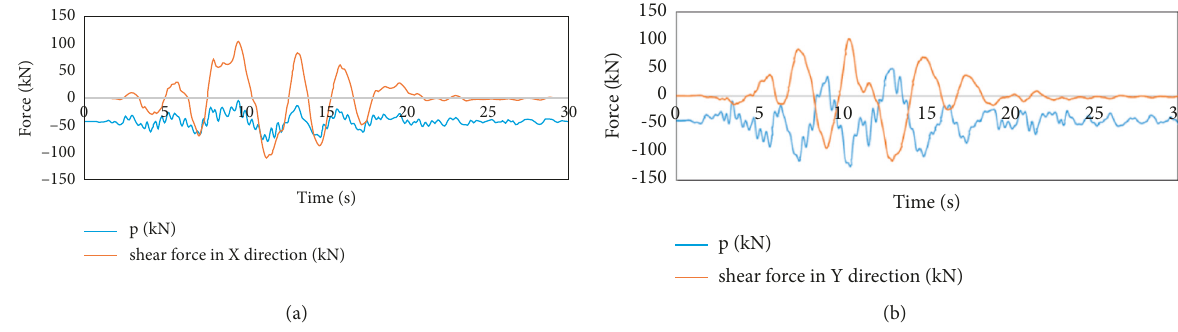
Figure 39: REN2 seismic waves under the bearing force time curve. (a) X-directional input. (b) Y-directional input.